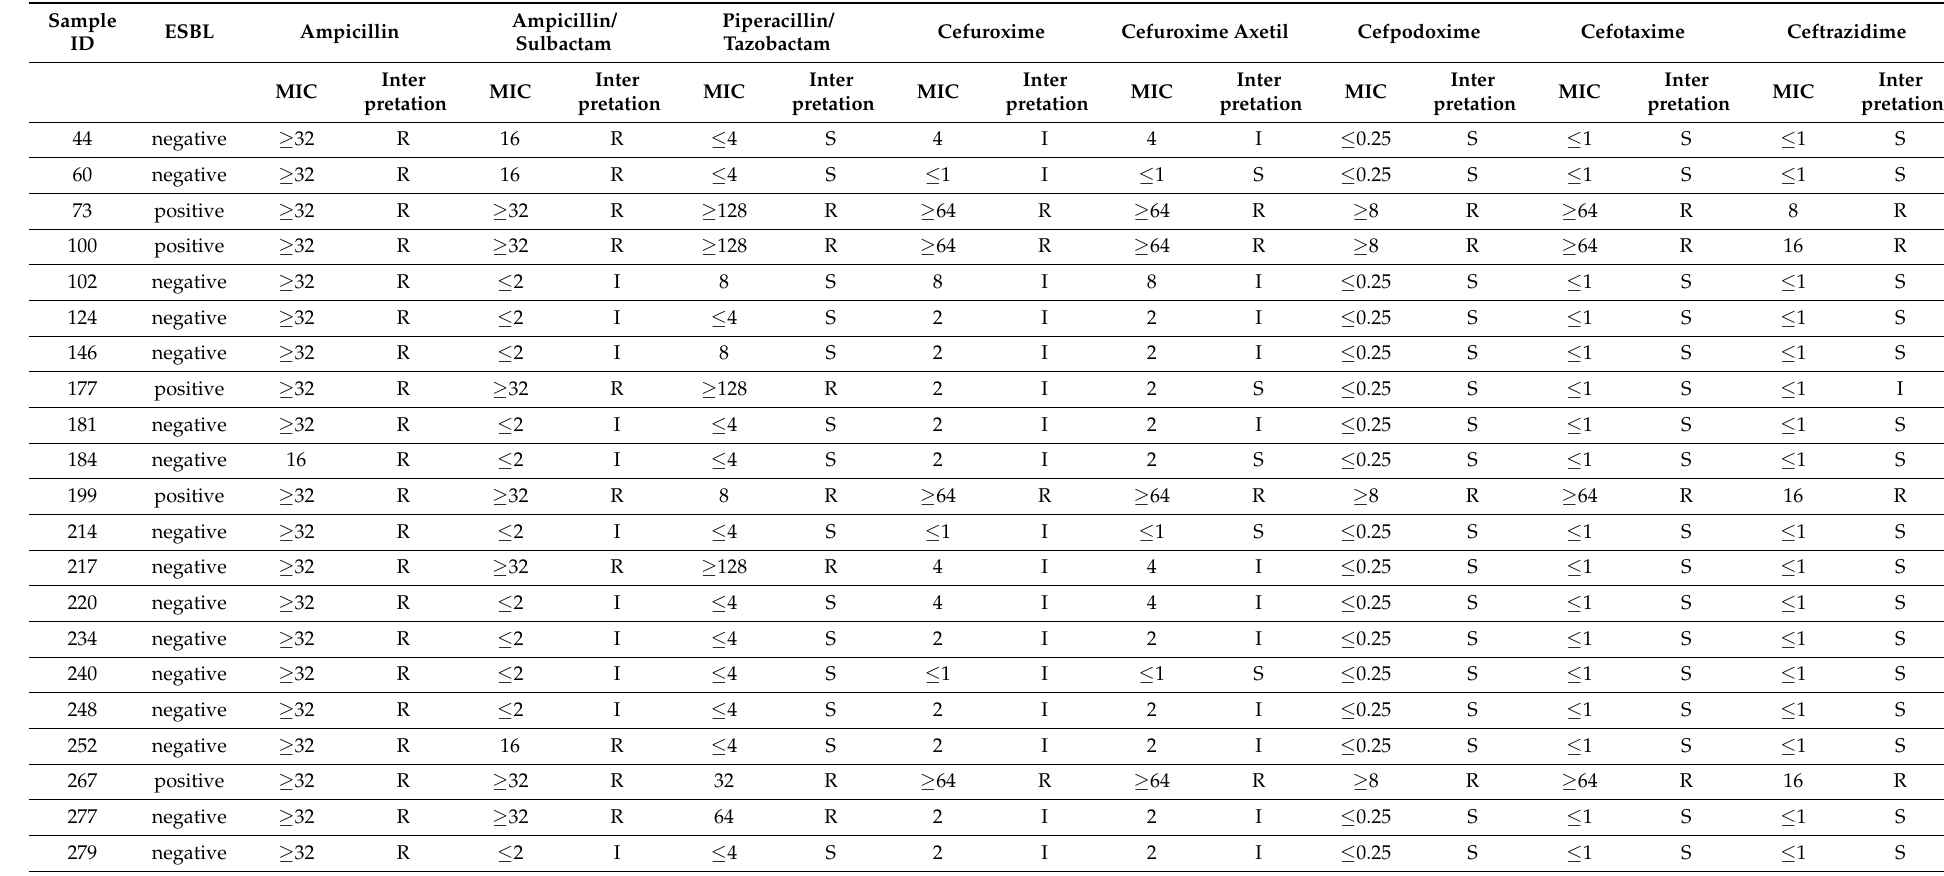
Table A5. Phenotypic resistance of the Klebsiella strains. MIC = minimum inhibitory concentration. ESBL = signal in phenotypic testing for extended-spectrum